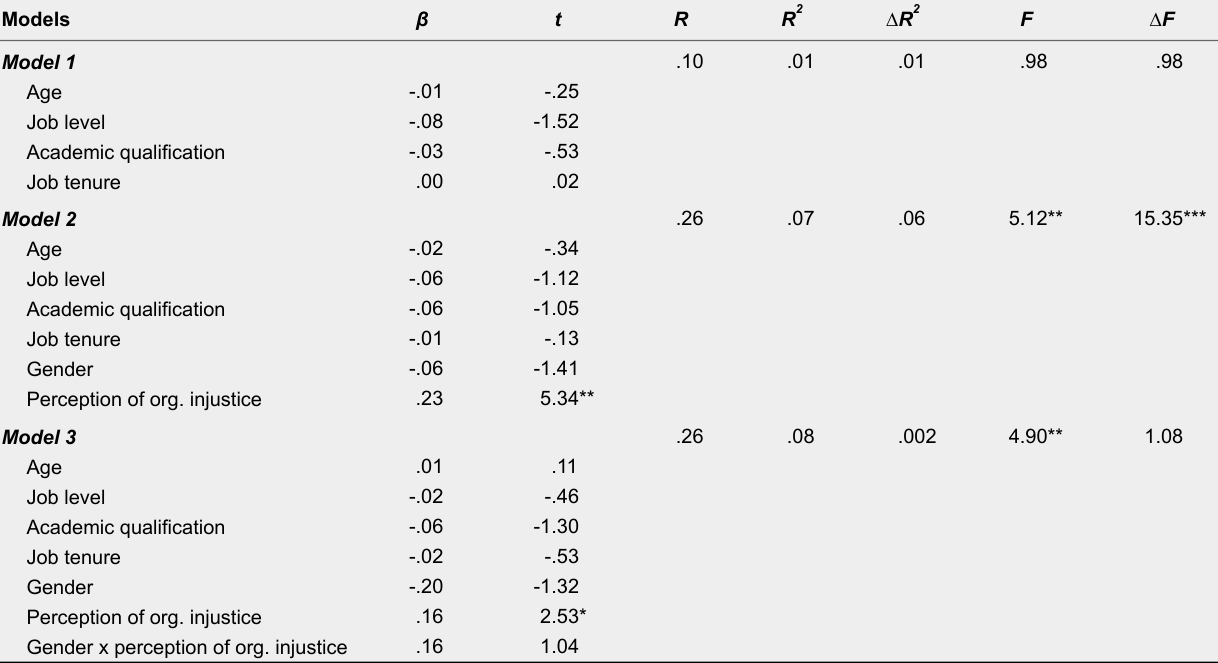
Hierarchical Multiple Regression on Interpersonal Revenge